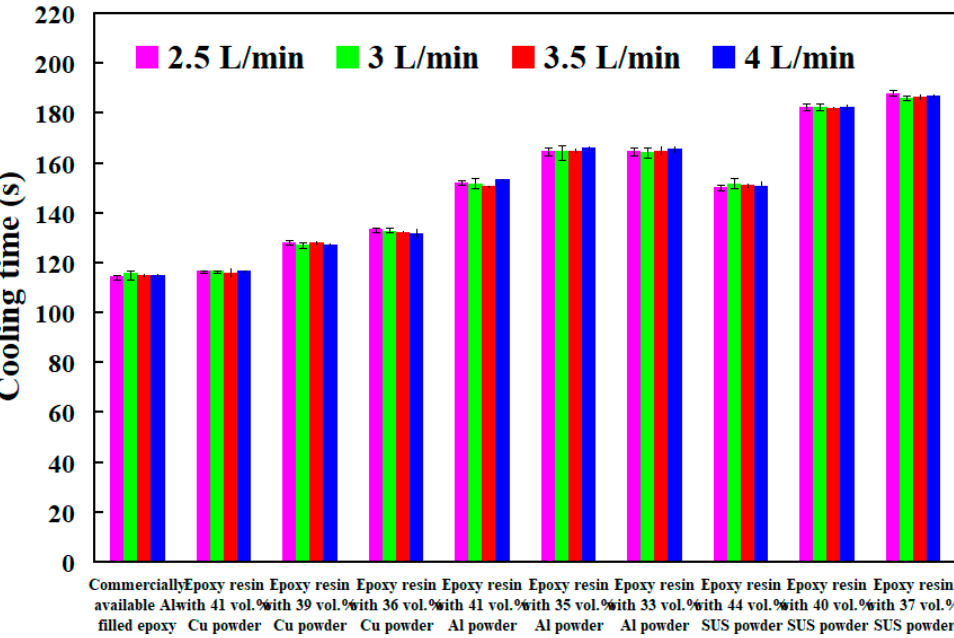
Figure 20. Cooling time of injection molded parts fabricated by ten sets of injection molds cooled with different flow rates of cooling water with ultrafine bubbles.